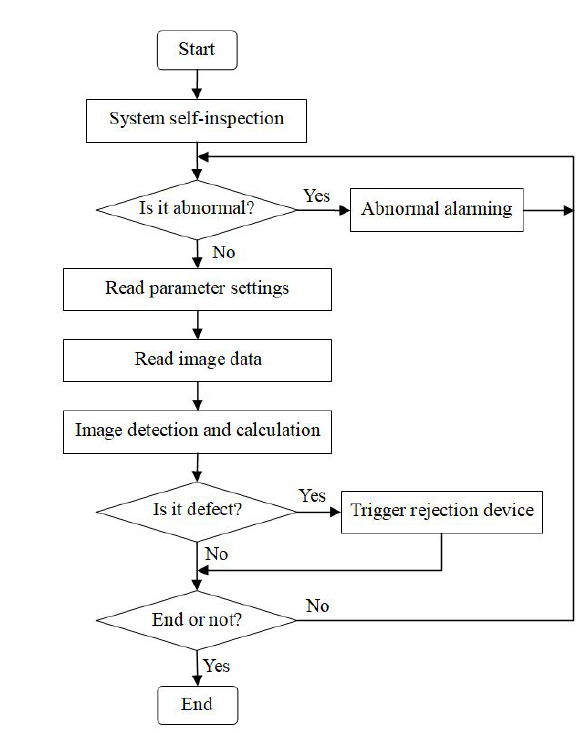
Fig. 6. The workflows of the program